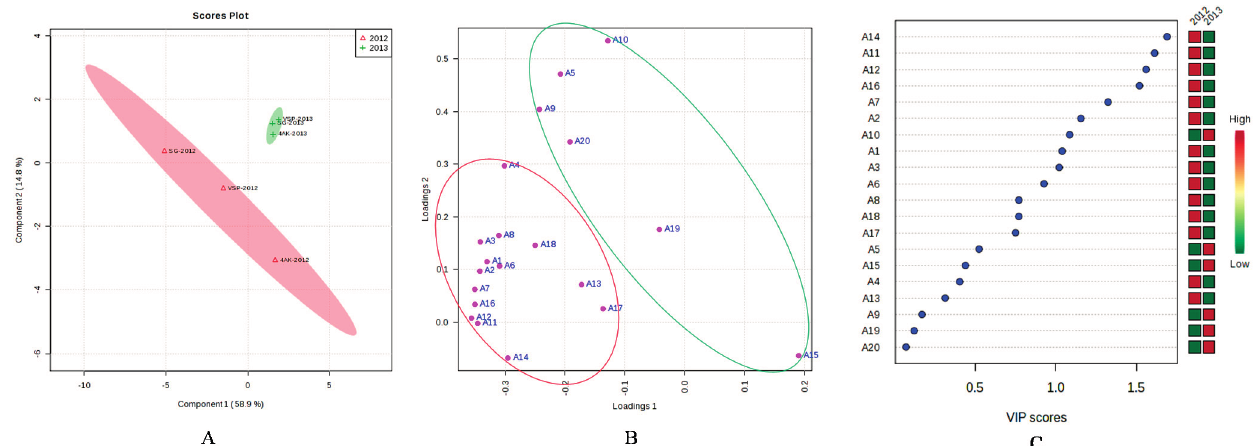
Figure 5. Results of discrimination of the grape samples from three training systems by the concentrations of individual anthocyanin detected in two vintages using PLS-DA analysis. ( A ) Scores plot; ( B ) Loading plot; ( C ) Selected compounds base on VIP